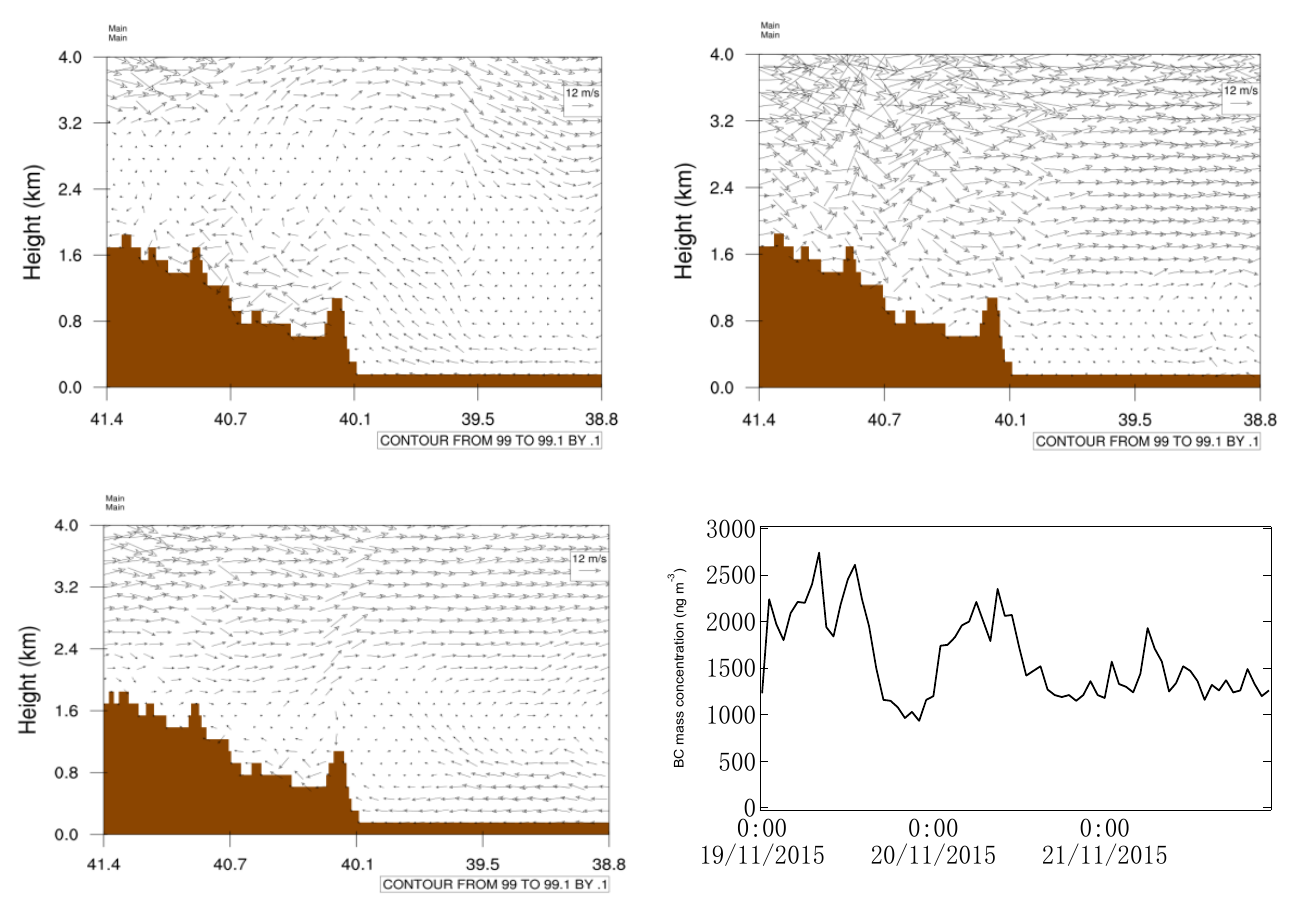
Figure 7. Mass concentration time series of BC in Beijing urban area on the 19th to 21st.